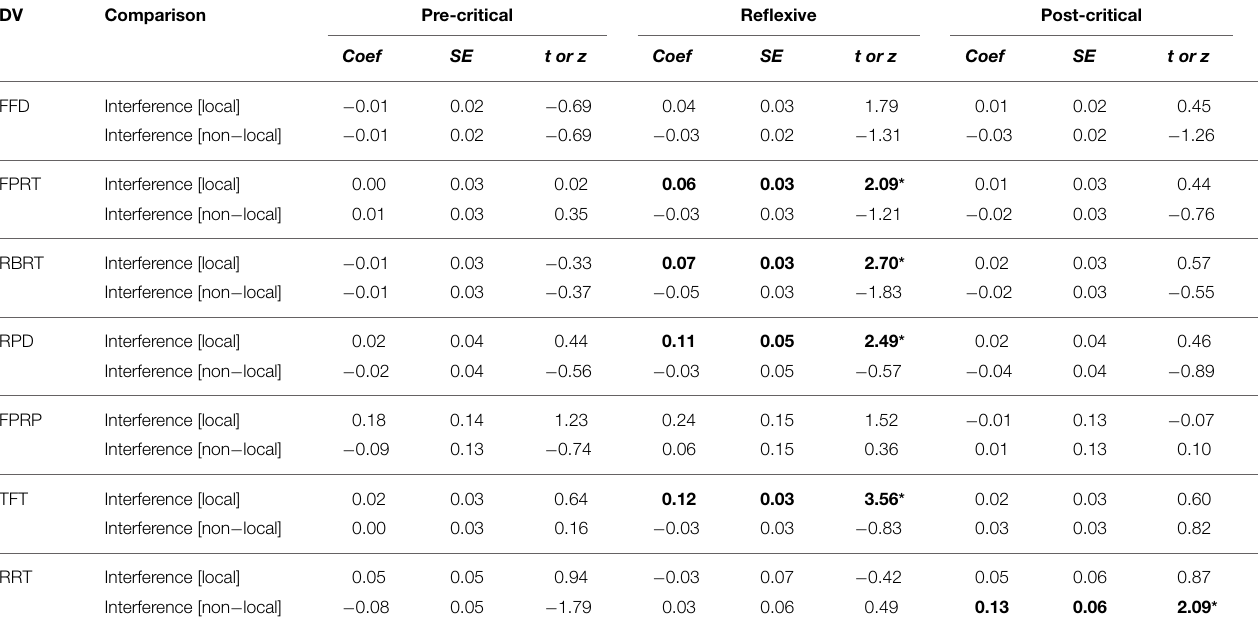
TABLE 10 | Experiment 2: Interference effect nested within each level of locality (local vs. non-local) at the pre-critical ( ziji − 1), critical ( ziji ), and post-critical ( ziji + 1) regions for the dependent variables (DVs) first-fixation duration, first-pass reading time, right-bounded reading time, regression-path duration, first-pass regression probability, total fixation time, and re-reading